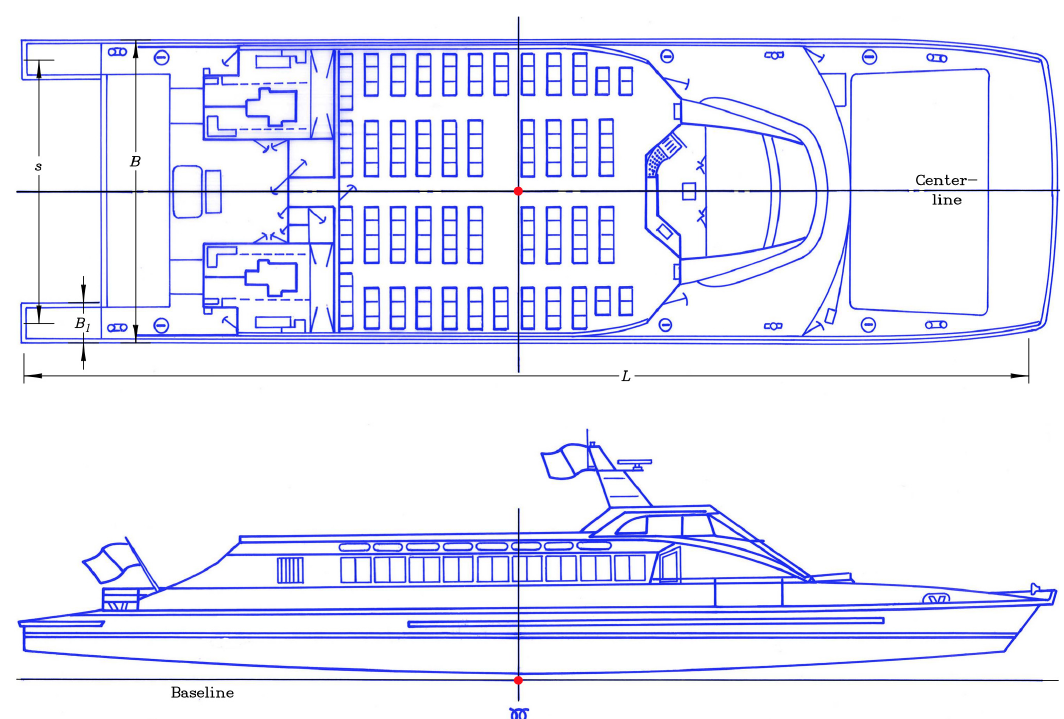
Figure 2. General arrangement of the Sydney